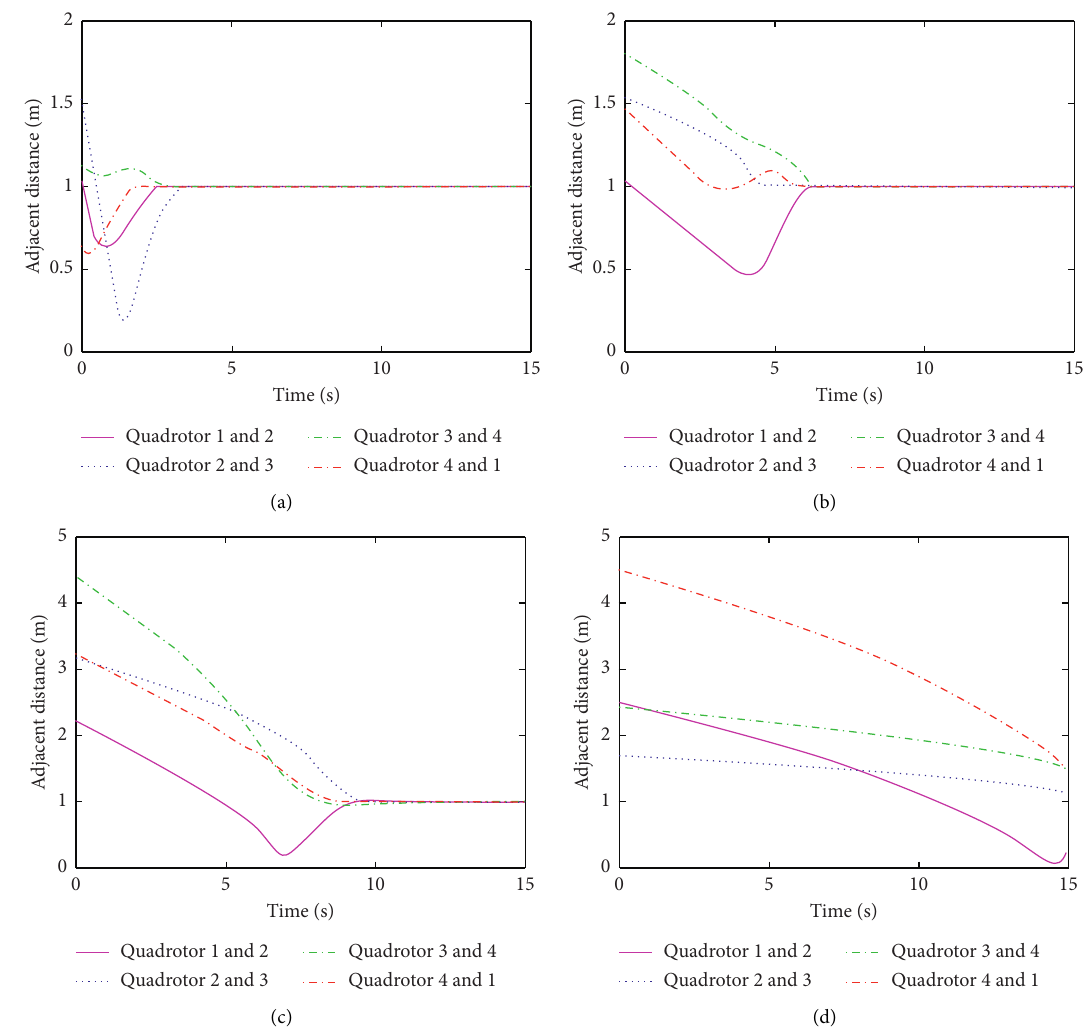
Figure 4: The adjacent distance between every two quadrotors under the control algorithm (34). (a) In the range of (0, 2). (b) In the range of (3, 5). (c) In the range of (5, 10). (d) In the range of (10,